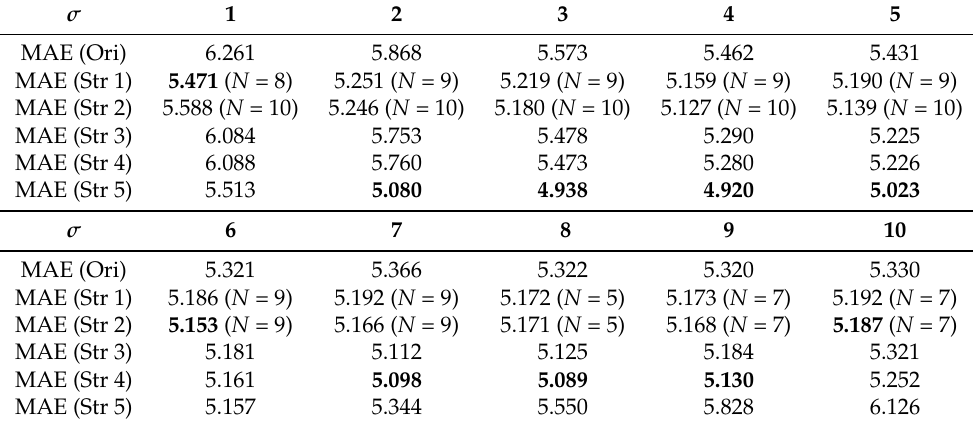
Table 5. Mean Absolute Errors (MAEs) of the compared original LDL algorithm without decision-making strategy and the proposed SDM-LDL algorithms with different strategies on the condition that age label distribution is generated as Gaussian-like ( σ from 1 to 10; for Strategies 1 and 2, best results are shown in the table along with the value of N then; for every σ , the optimal MAEs are marked in bold).